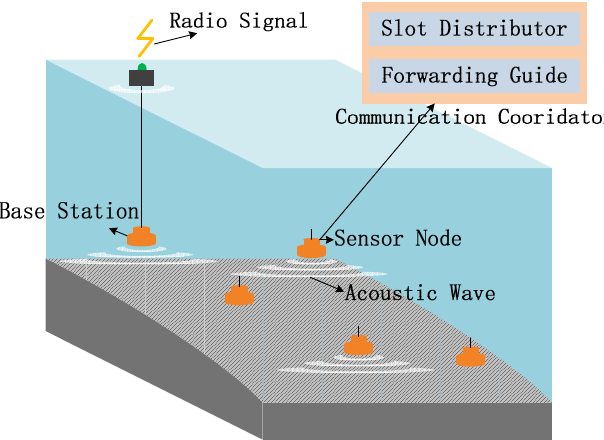
Figure 1. Illustration of a wireless underwater sensor network. Nodes are randomly deployed and float at a certain depth. The nodes communicate with each other via underwater acoustic communication. There is a special node called a base station that is connected with a radio antenna floating at the surface of the water. Information obtained by sensor nodes is sent to the base station, and the base station sends messages to the control center via radio. As communication collision can happen if acoustic signals are sent improperly, each node is equipped with a controller called a communication coordinator, which is used to control when and what a node broadcasts via acoustic signals. The communication coordinator is designed in this